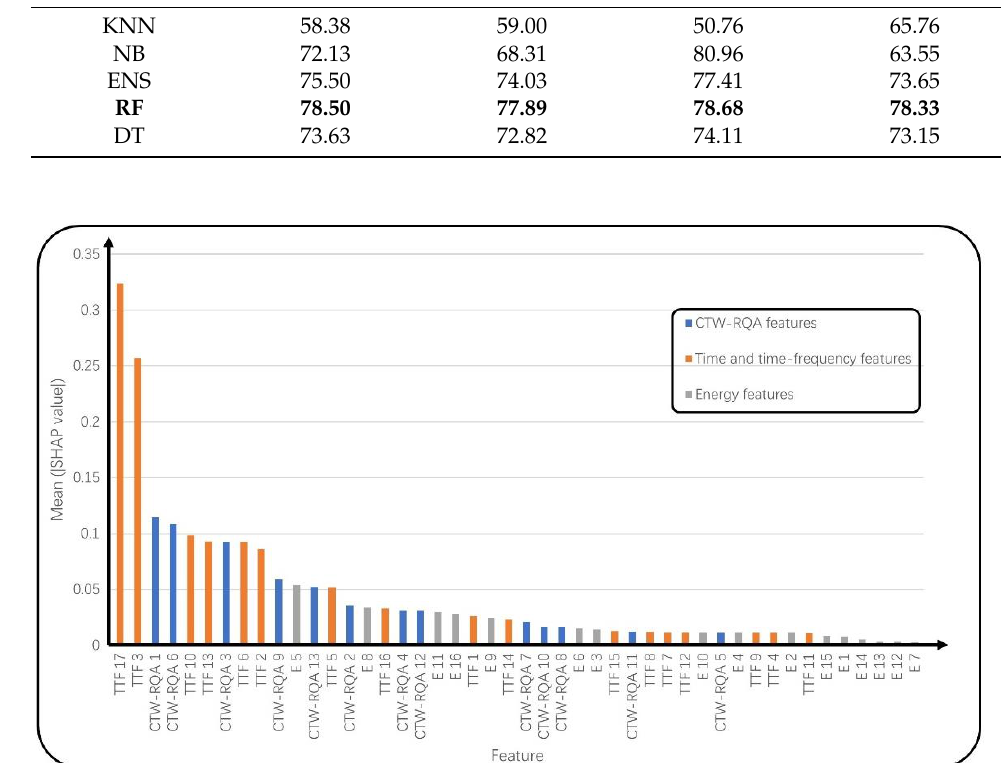
Figure A1. The ranking results of fusion features based on the SHAP summary plot. Table A1. AF detection performance based on RQA features.